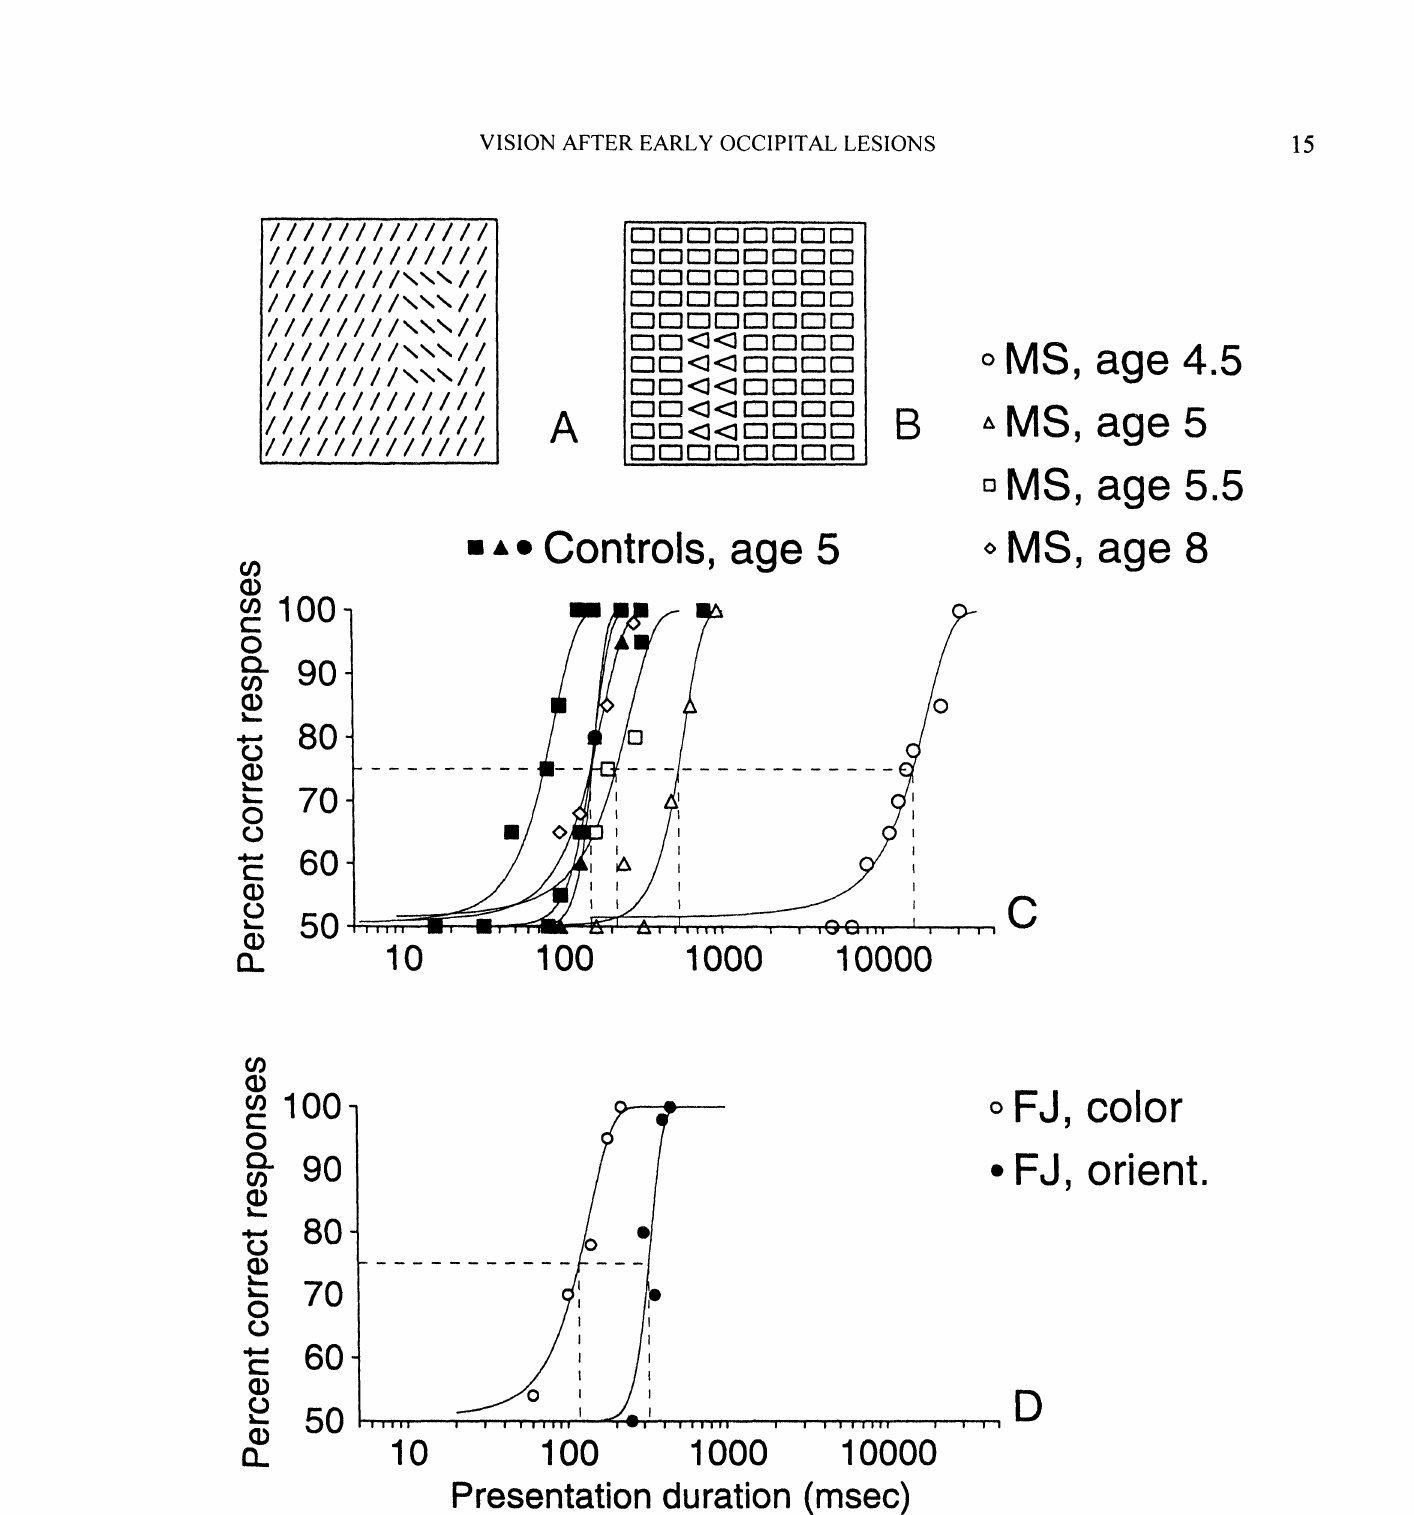
Fig. 5: Performance of MS, FJ in the rectangle orientation task. (A), (B): The stimuli. See text for explanation. (C) Performance of 3 control subjects (all aged 5) and of MS at ages 4:5, 5, 5:5, and 8, using the stimulus shown in (A). Horizontal dashed line, 75% correct threshold level; Vertical dashed lines, MS thresholds. See text for explanation. (D) Performance of FJ at age 19 on the same task using stimulus (A) () and showing a rectangle defined by elements (small squares) varying in color (O). Notice that the performance with (A) is close to that of MS at age 5, whereas the performance using colors is